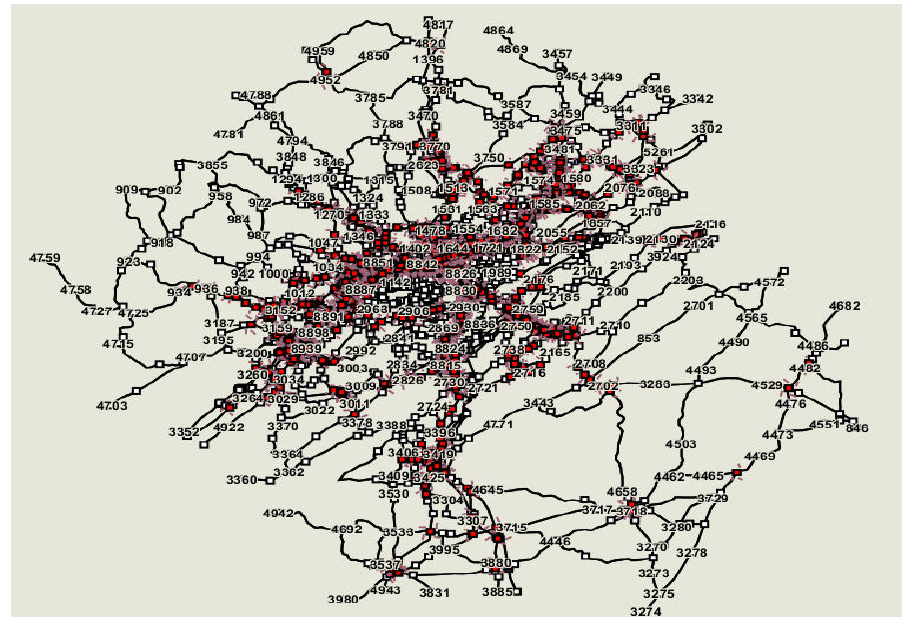
Figure 1. Birmingham network coded in VISTA.